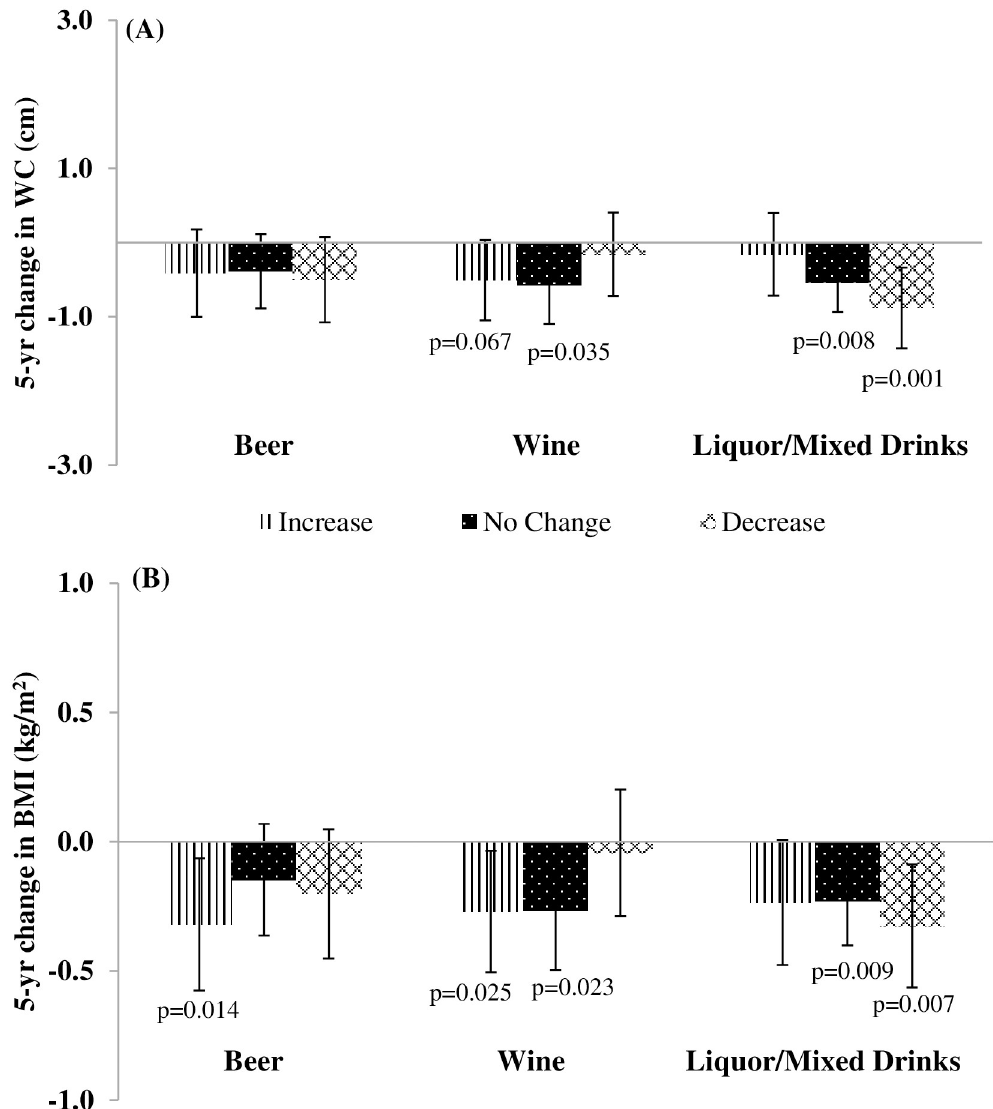
Fig 4. Adjusted associations of 5-yr changes in alcoholic beverage intake by type with 5-yr changes in (A) Waist Circumference (WC) (cm) and (B) Body Mass Index (BMI) (kg/m 2 ) for women in the CARDIA Study from 1985–1986 to 2010–2011. Data from women (N = 2,381) for 5-yr changes in changes in (A) WC and (B) BMI from CARDIA exam yrs 5, 10, 15, 20 and 25. Values are β coefficients (95% CI) obtained from longitudinal random effects linear regression models adjusted for baseline age cohort membership, baseline WC, race and study center and time-varying income, education, smoking status and time-varying changes in marital status, physical activity, diet quality and intake of each other alcoholic beverage type. When 5-yr change in BMI was the outcome, models were adjusted for baseline BMI instead of baseline WC. Estimates compared to the referent 5-yr change among “stable non-drinking”. For stable non-drinking women, the adjusted mean 5-yr WC change was +3.78 ± 0.14 cm and the adjusted mean 5-yr BMI change was +1.49 ± 0.06 kg/m 2 . P-values correspond to the 2-tailed p-values used in testing the null hypothesis that β is 0. β estimates having p-values < 0.05 were considered statistically